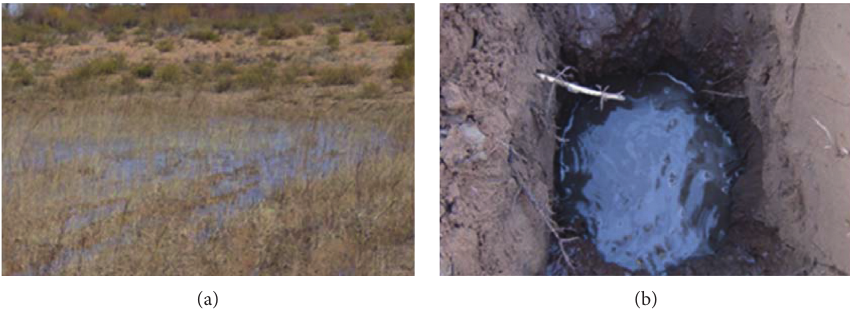
Figure 2: Weak soil in the test area. Table 1: Basic physical parameters. Table 3: Mud content in each testing